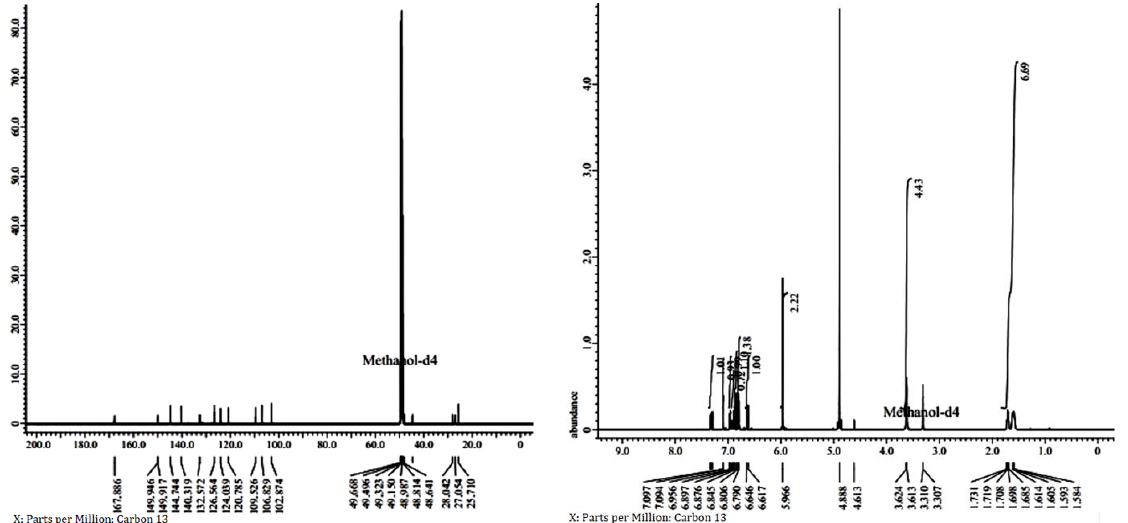
Figure 6. The molecular structure of isolated piperine